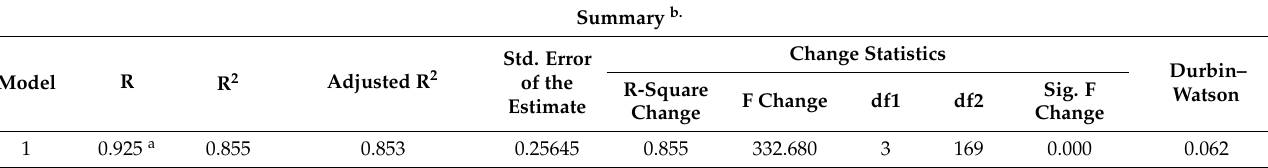
Table 9. Summary of model used.